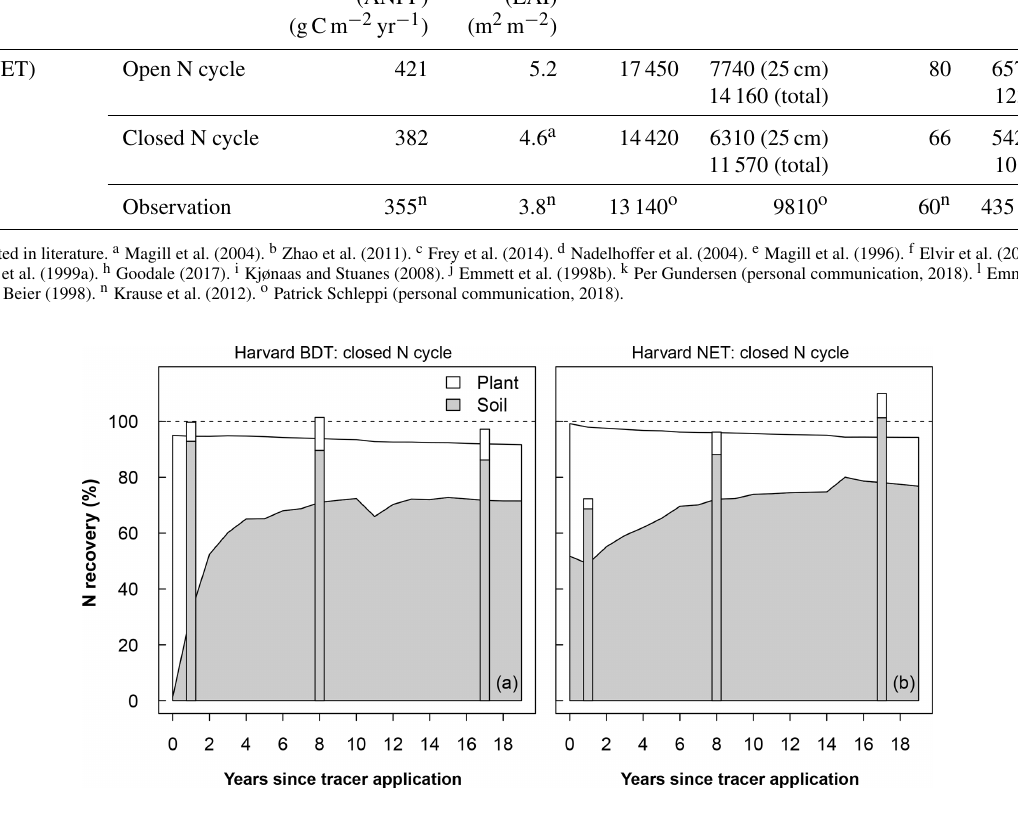
Figure 2. Modeled recovery of N additions for Harvard Forest broadleaf deciduous temperate tree (BDT; a ) and needleleaf evergreen temperate tree (NET; b ). Simulations were done using a closed N cycle and are compared to observations (stacked bars). The modeled soil stock includes the organic soil, inorganic soil, and litter pools (excluding coarse woody debris). Recovery is calculated as the difference in stock size between a control simulation and a simulation with a tracer added as 0.5gm − 2 between April and September in year 0. Plots of recoveries at all other sites and for the version of CLM5 with an open N cycle at Harvard Forest are shown in Figs.